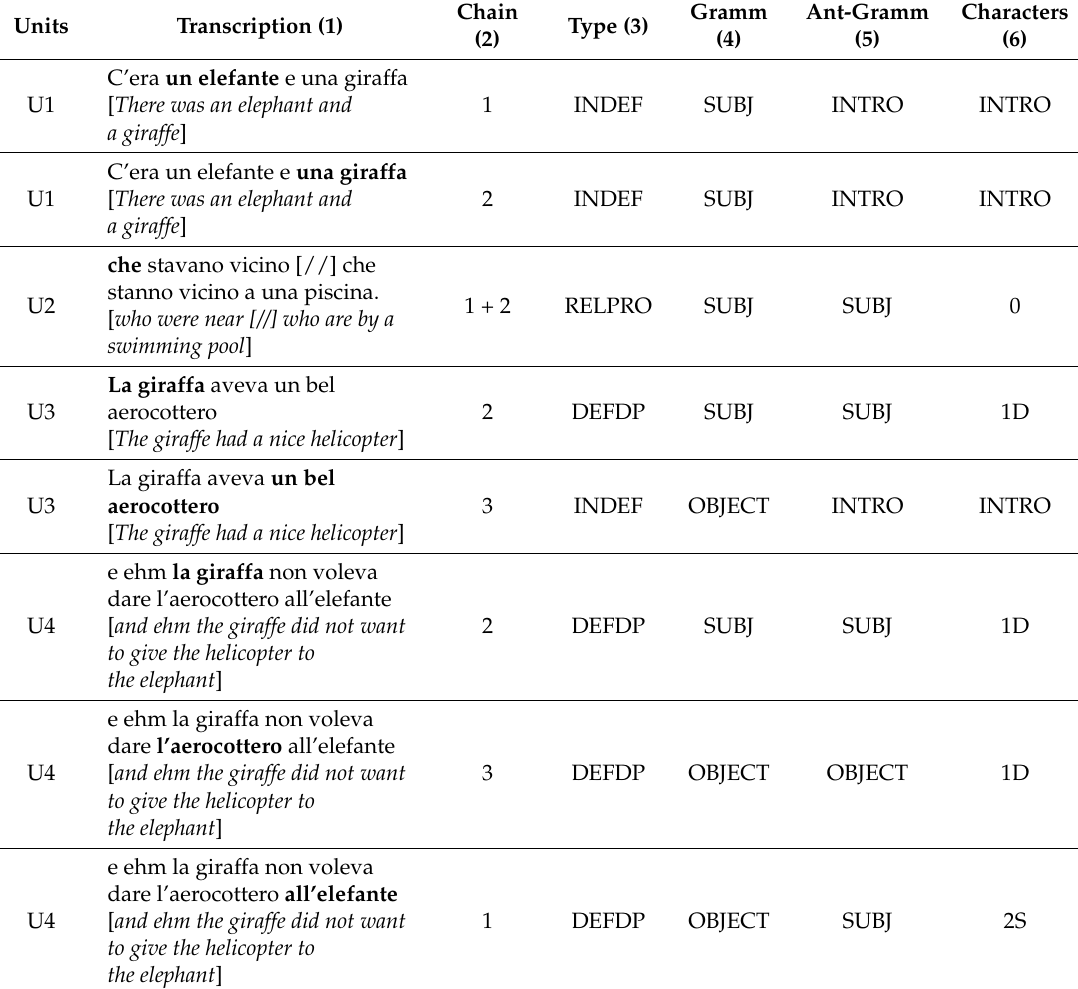
Table 3. Example of coding. The story is told by a 12-year-old German-Italian bilingual speaker (F1). Units containing more than one referring expressions are repeated as many times as the number of referring expressions they